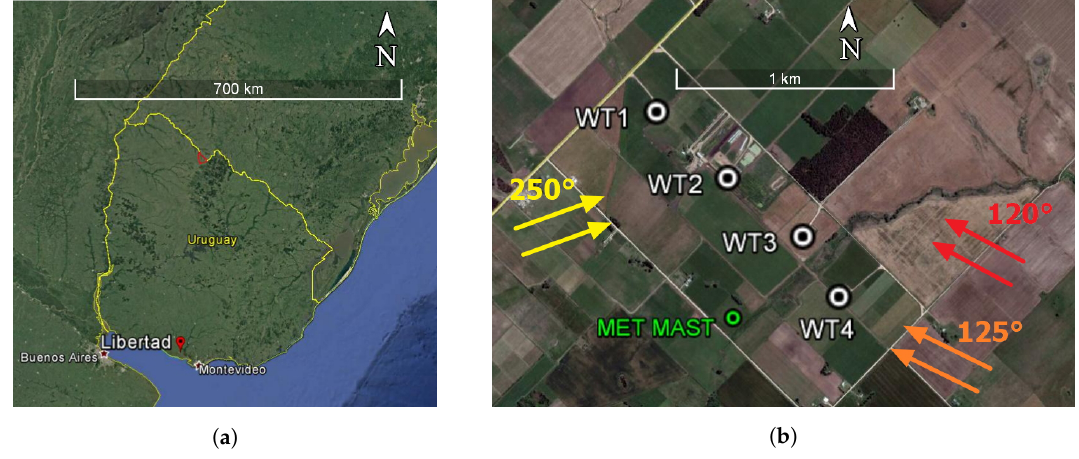
Figure 2. Libertad wind farm location ( a ) and layout ( b ). The arrows indicate the simulated wind directions (adapted from